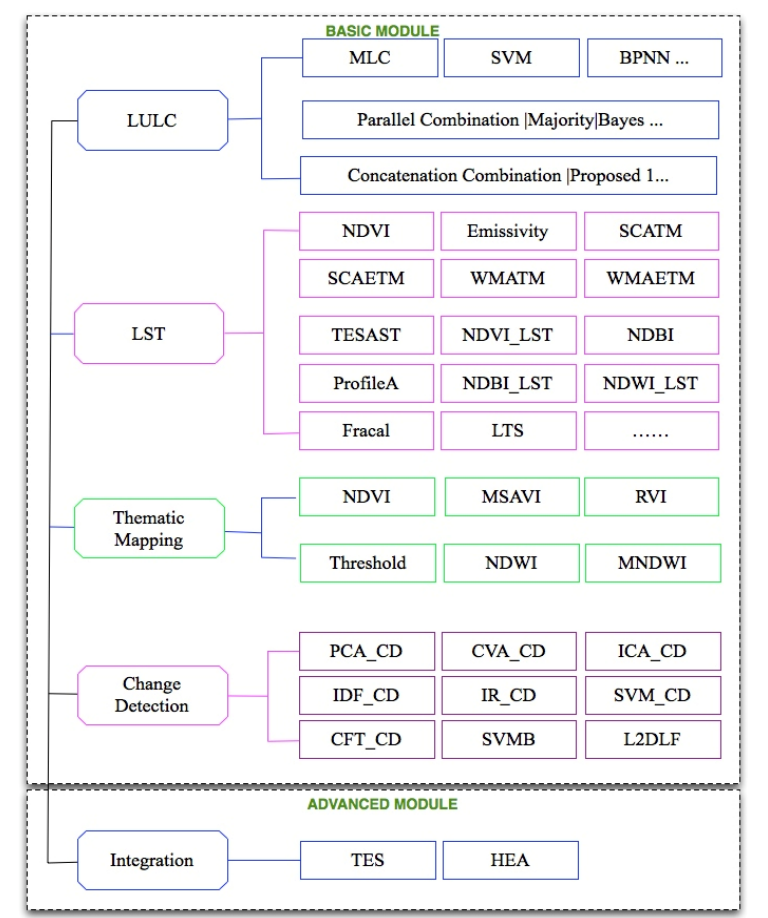
Figure 1. A chart of urban environment analysis related remote sensing image processing